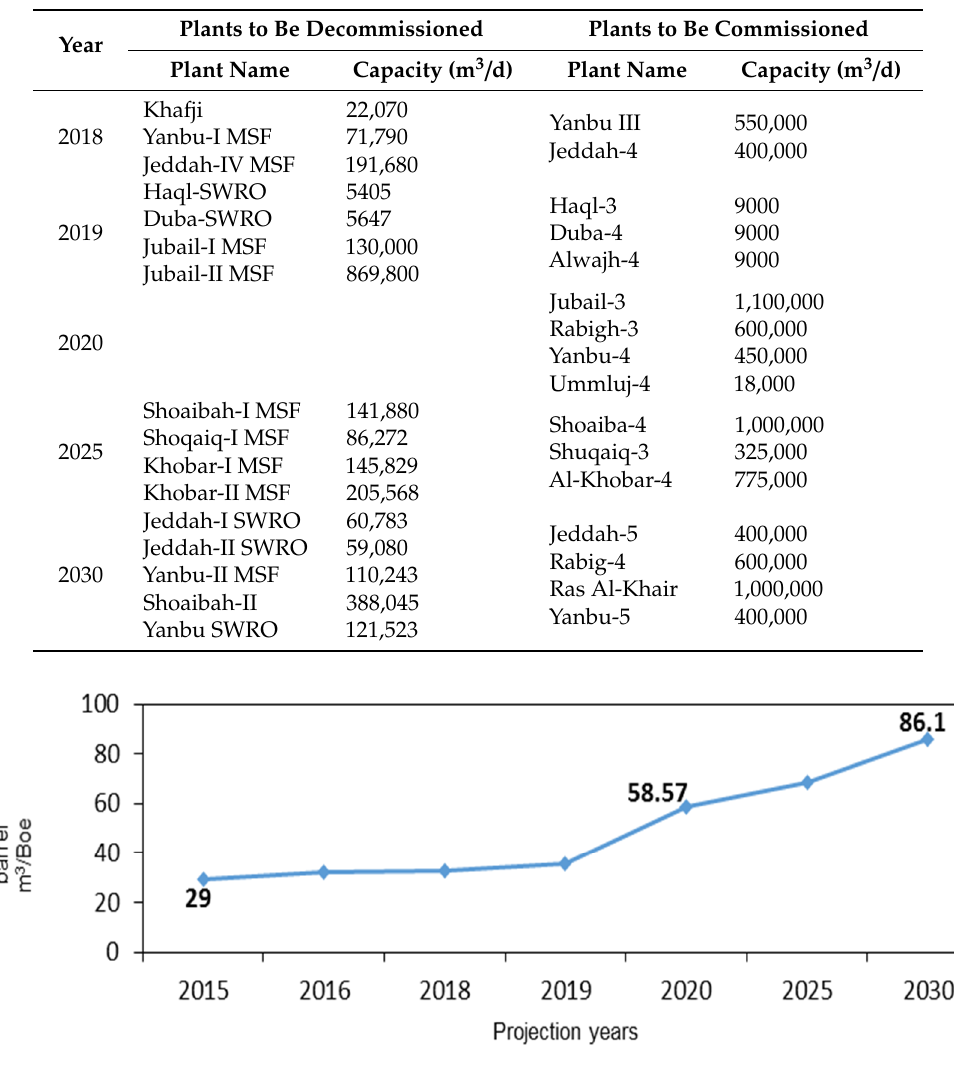
Table 2. Projected decommission and commission plan in Saudi Arabia (SA), 2018 to 2030. SWCC, Saline Water Conversion Corporation; MSF, multi-stage flashing.